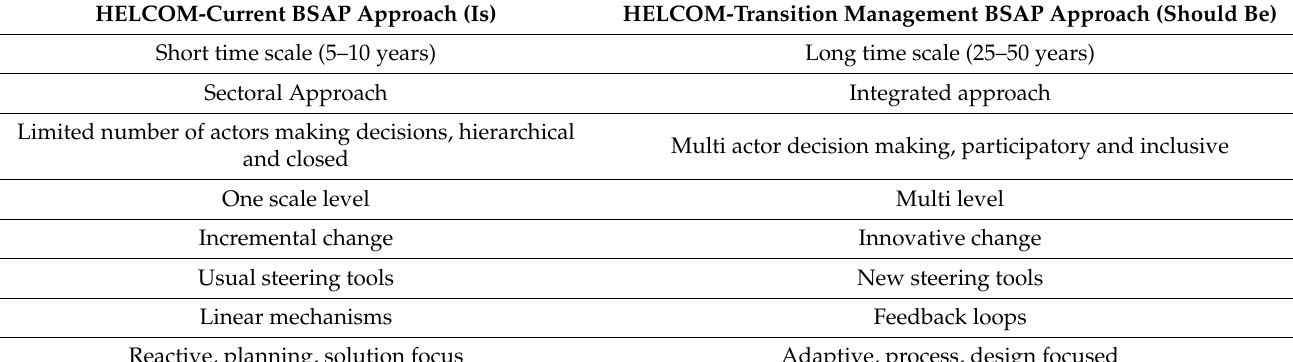
Table 2. The Helsinki Commission (HELCOM) in current vs. transition management Baltic Sea Action Plan (BSAP)